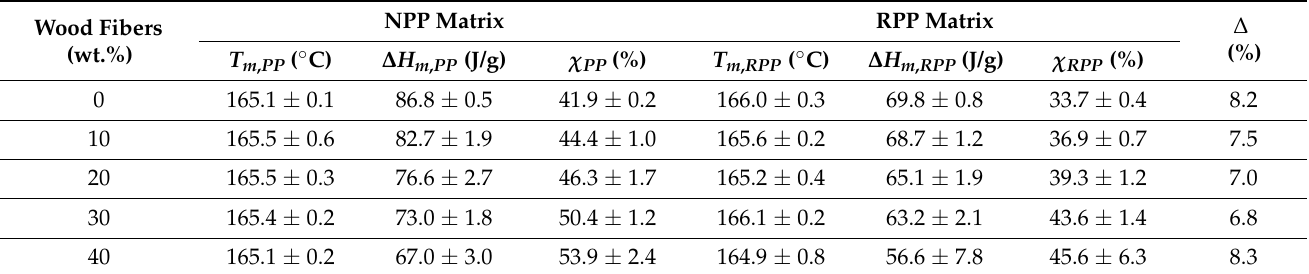
Table 3. Thermal characteristics of composites with neat (NPP) and recycled (RPP) polypropylene matrix. Wood